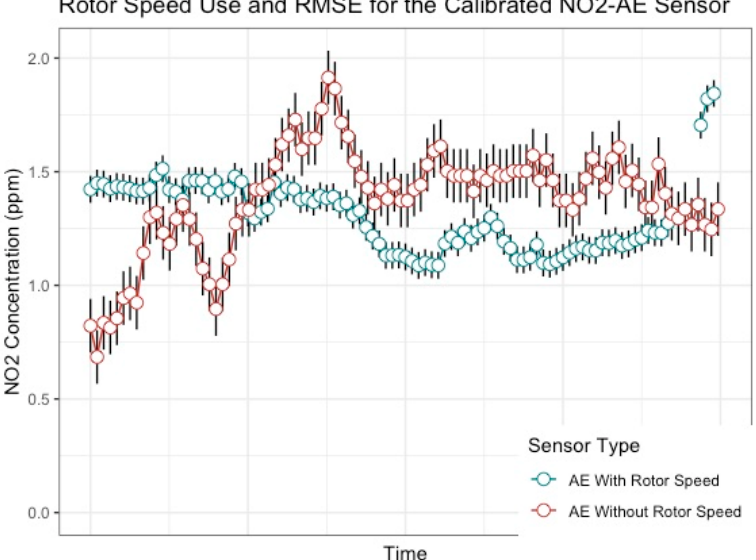
Figure 5. Comparing NO 2 concentration for the calibrated NO 2 -AE sensor using the best model where rotor speed is used, and the second-best model, where rotor speed is not used. The RMSE is indicated as error bars for each data point.